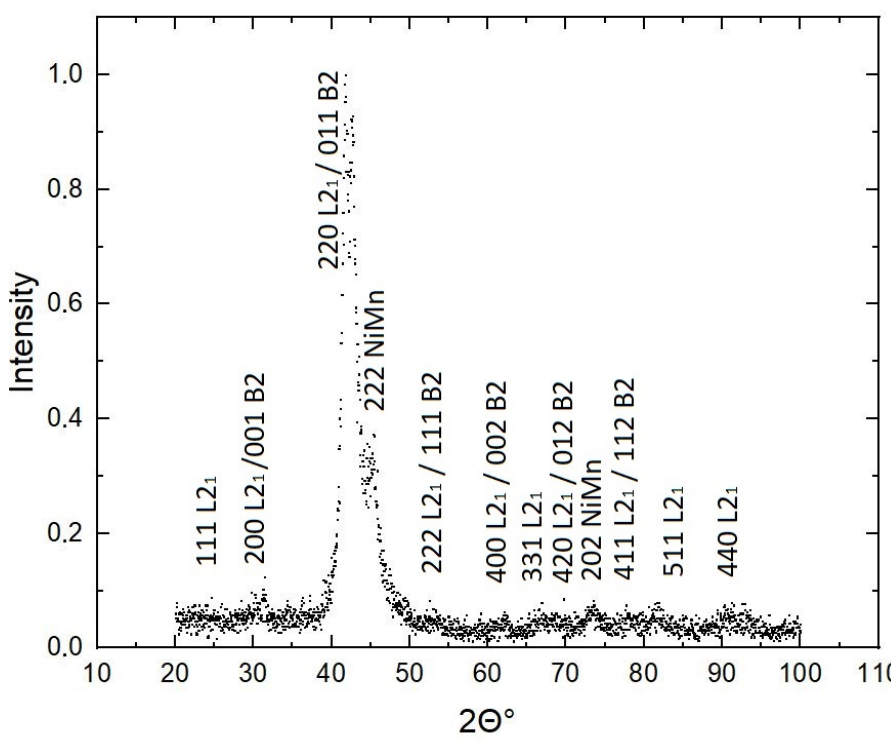
Figure 3. X-ray diffraction pa(cid:308)ern of the Ni 46 Mn 41 In 13 alloy at room temperature.